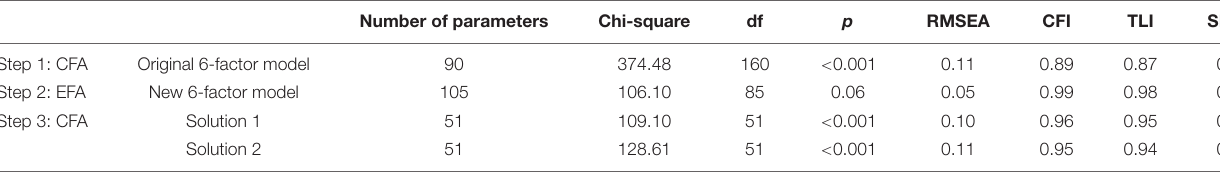
TABLE 6 | Model fit indices for the TTS internal structure validation.